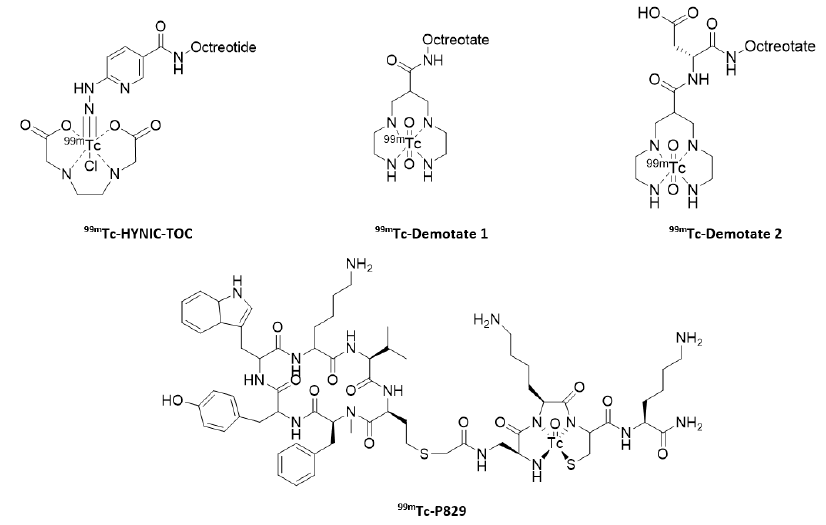
Figure 8. [ 99m Tc]-labeled somatostatin analogs.